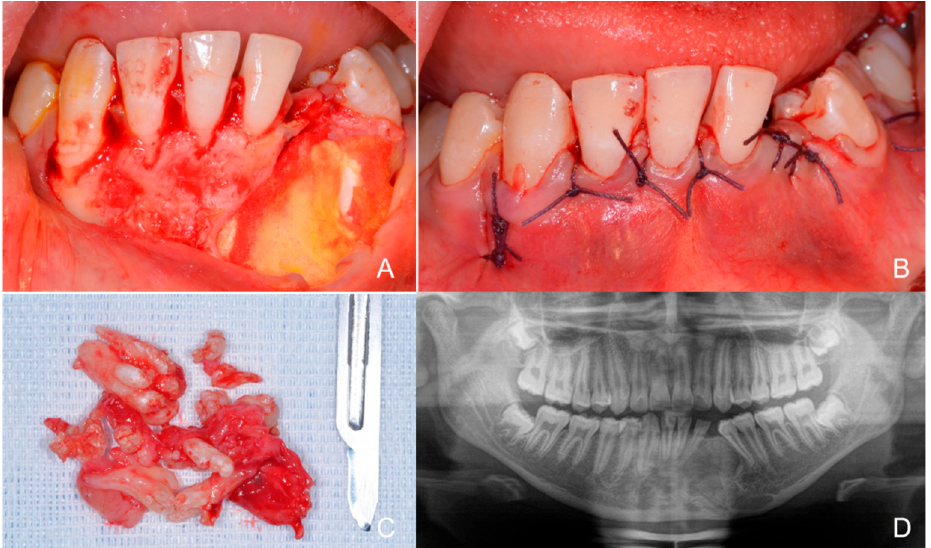
Figure 8. Post-surgery images. ( A ) The bone defect is filled with a fibrin sponge (Spongostan Dental, absorbable haemostatic gelatine sponge, Ethicon, Somerville, MA, USA), which guarantees a good clot; ( B ) The suture (Vicryl Ethicon 3.0, 17 mm 1/2c, Johnson & Johnson International, Hamburg, Germany) that recomposes the nature of the tissues is visible; ( C ) The odontoma clinical findings consisting of an ensemble of calcified structures, some like mini-teeth, some denticles appear as single-rooted, others as multi-rooted, some even fused, with no complete root formation and enamel, dentin, and cement being identified as dental tissues. ( D ) The orthopanoramic image after 6 months showing the progressive reconstruction of the bone anatomy of the area. The odontoma resulted in both dislocation and subsequent inclusion of 32 and 33, but also caused root displacement of 31, 41, and 34. Any type of orthodontic therapy is postponed; not only is bone formation required at all the entire area resulting from the surgical removal of the odontoma, but it is also necessary to check the vitality of the dental elements adjacent to the area itself.